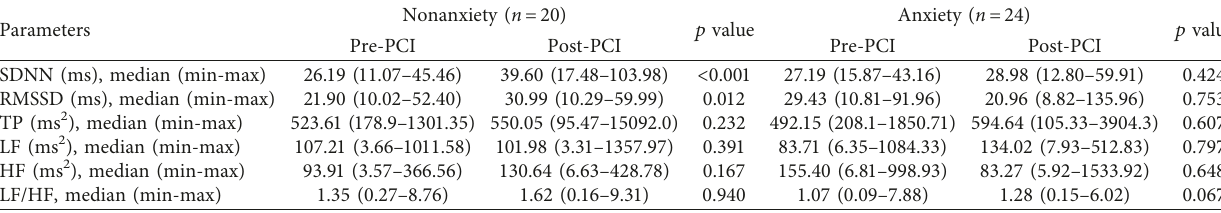
Table 3: Comparison of HRV before and after PCI.